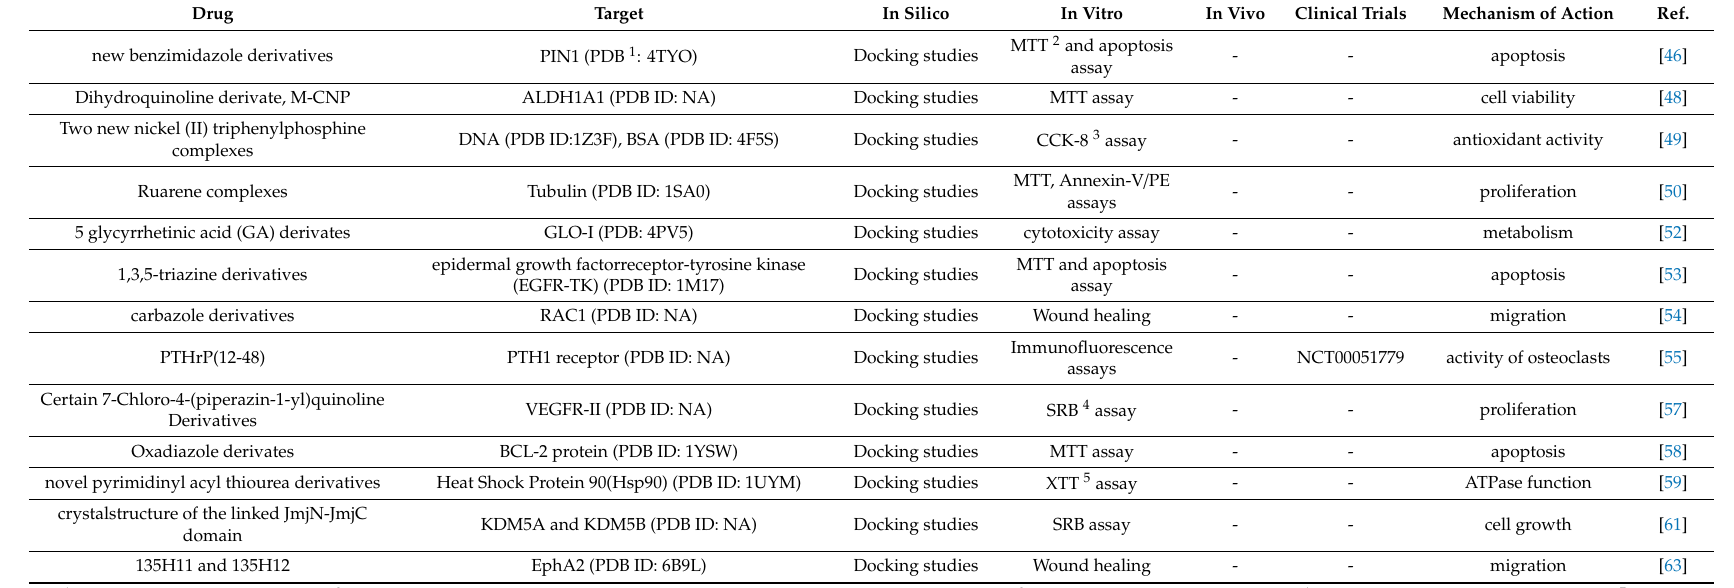
Table 3. Characteristics of studies reported in the review categorized as "new synthesized molecules" used in metastatic breast cancer. The table reports the drug, its target with PDB ID, in silico / in vitro / in vivo methods used to test the drug, clinical trials, mechanism of action and